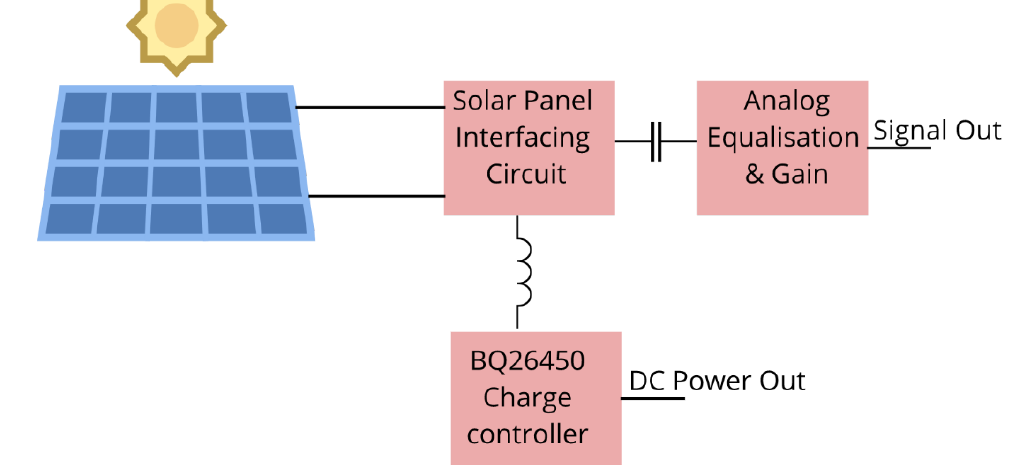
Figure 11. Receiver functional block diagram.